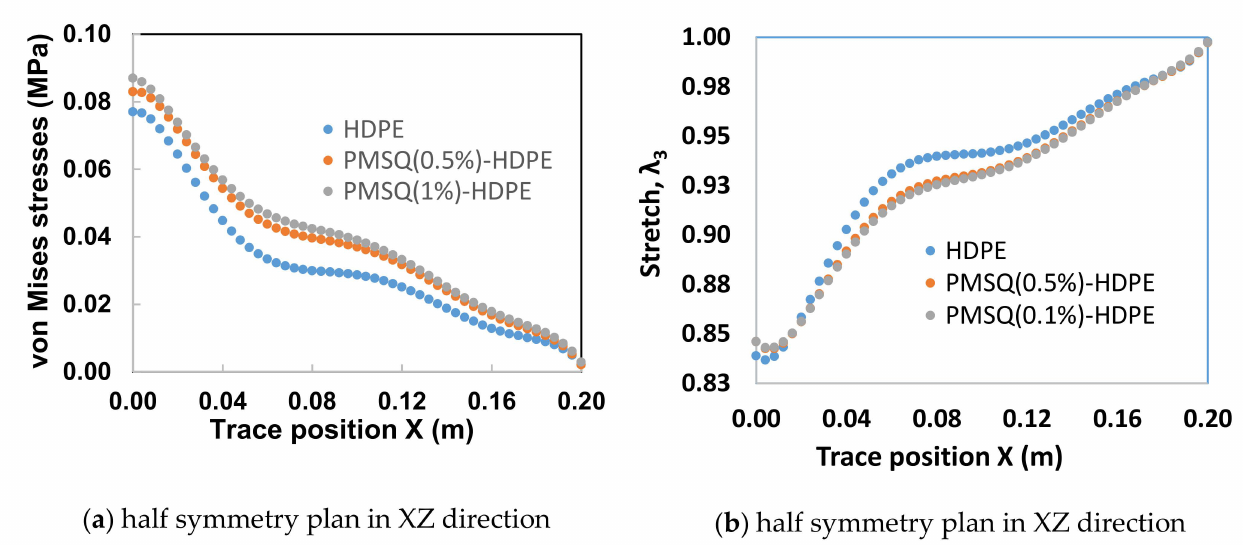
Figure 11. Main stretch ( λ 3 ) on the XZ and YZ half planes of